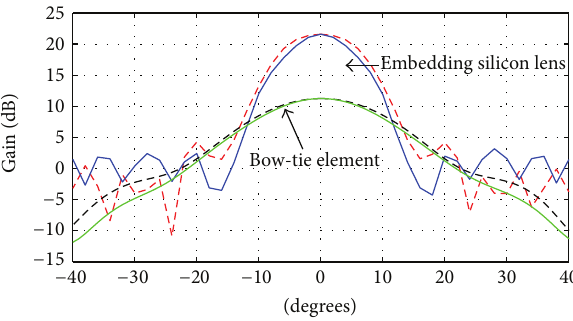
Figure 11: Simulated far field of E plane and H plane on bow-tie element and embedding silicon lens E plane (line), H plane (dashed